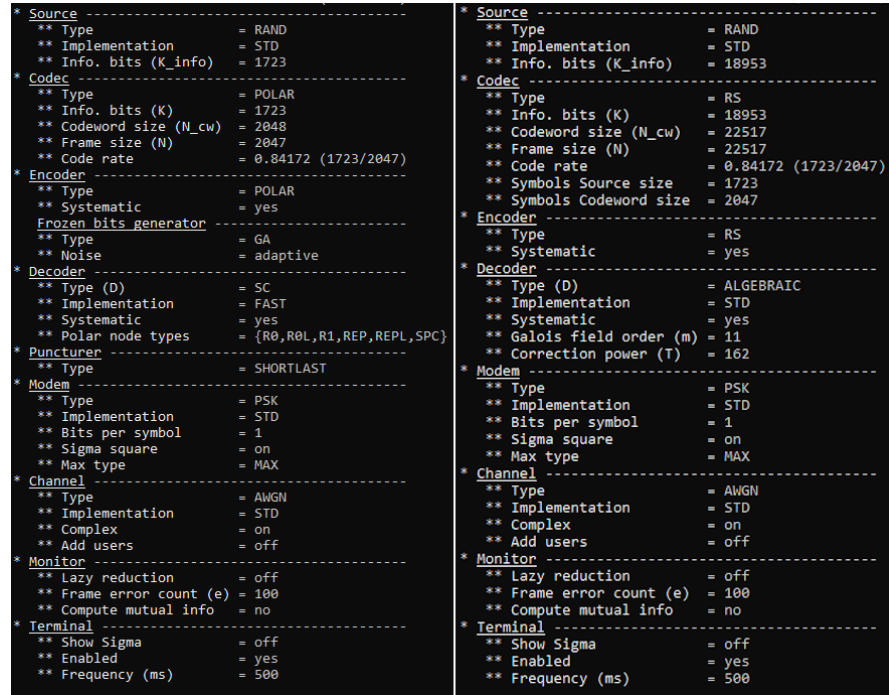
Figure 5. POLAR and RS simulation arguments.